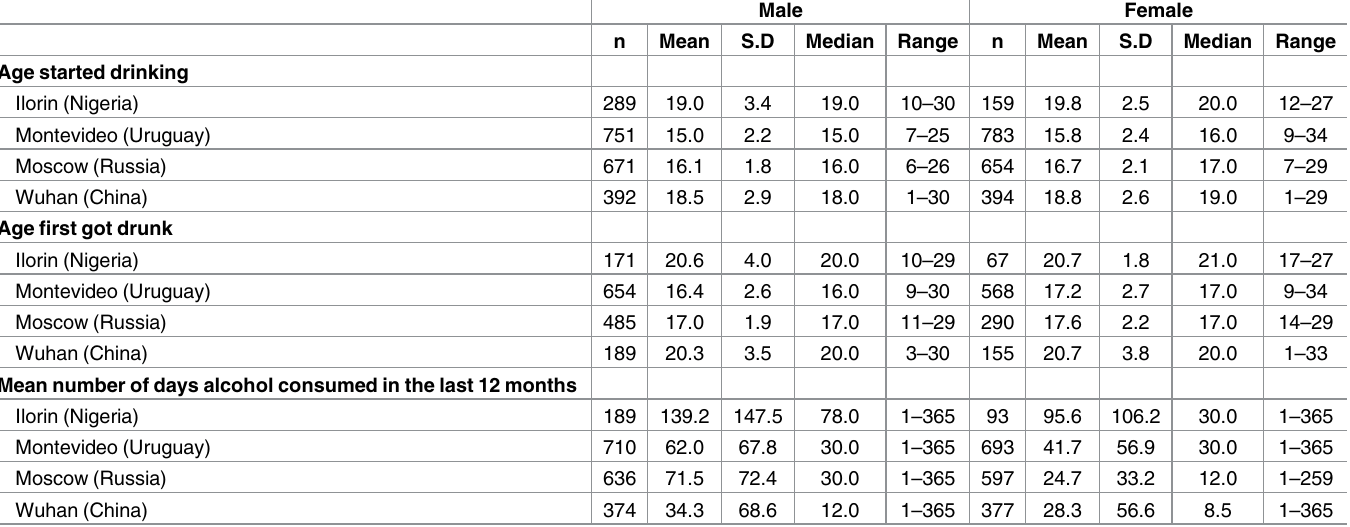
Table 3. Descriptivestatistics of age (in years) started drinking, age (in years)when first got drunk, and mean number of drinks consumed by gen- der and city/country.